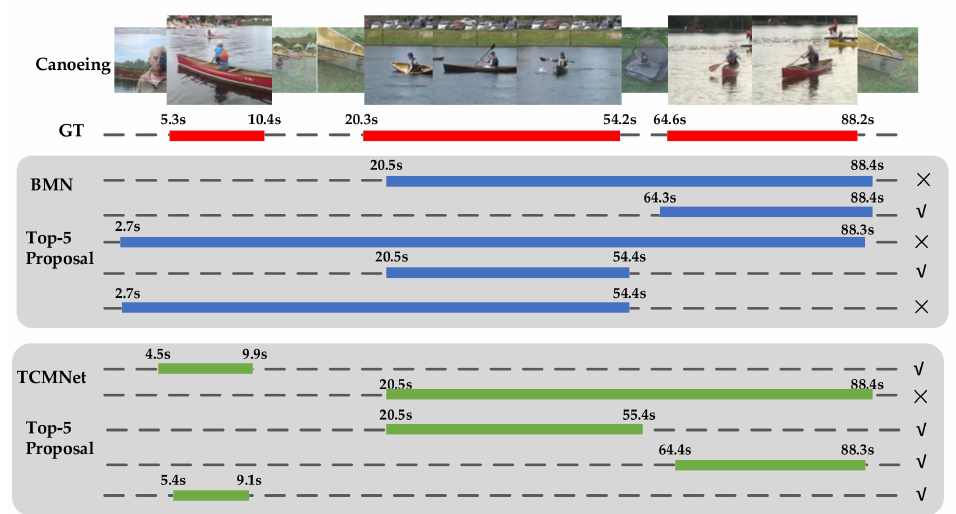
Figure 7. Qualitative results of BMN [28] and TCMNet on an example from the ActivityNet-1.3. The proposals shown are the top five predictions for corresponding ground truths.